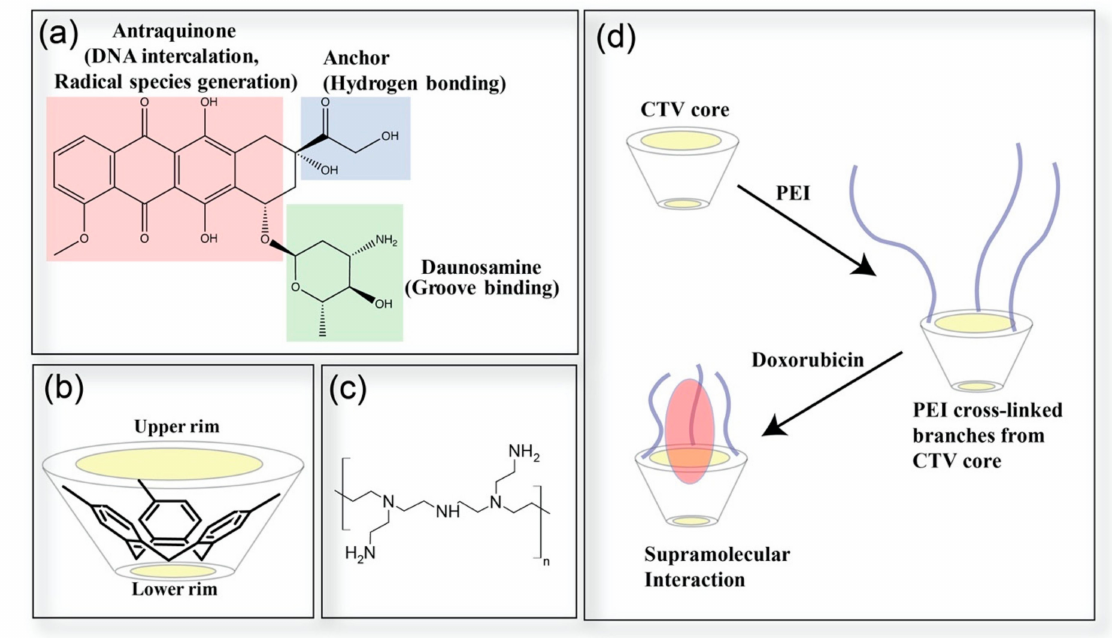
Figure 1. Molecular structures involved in this work: ( a ) Doxorubicin and biochemical function of each single molecular unit; ( b ) Cyclotriveratrylen (CTV) in the stable cup-shaped conformation; ( c ) Polyethylenimine; ( d ) Adduct Polyethylenimine (PEI)-CTV and Doxorubicin